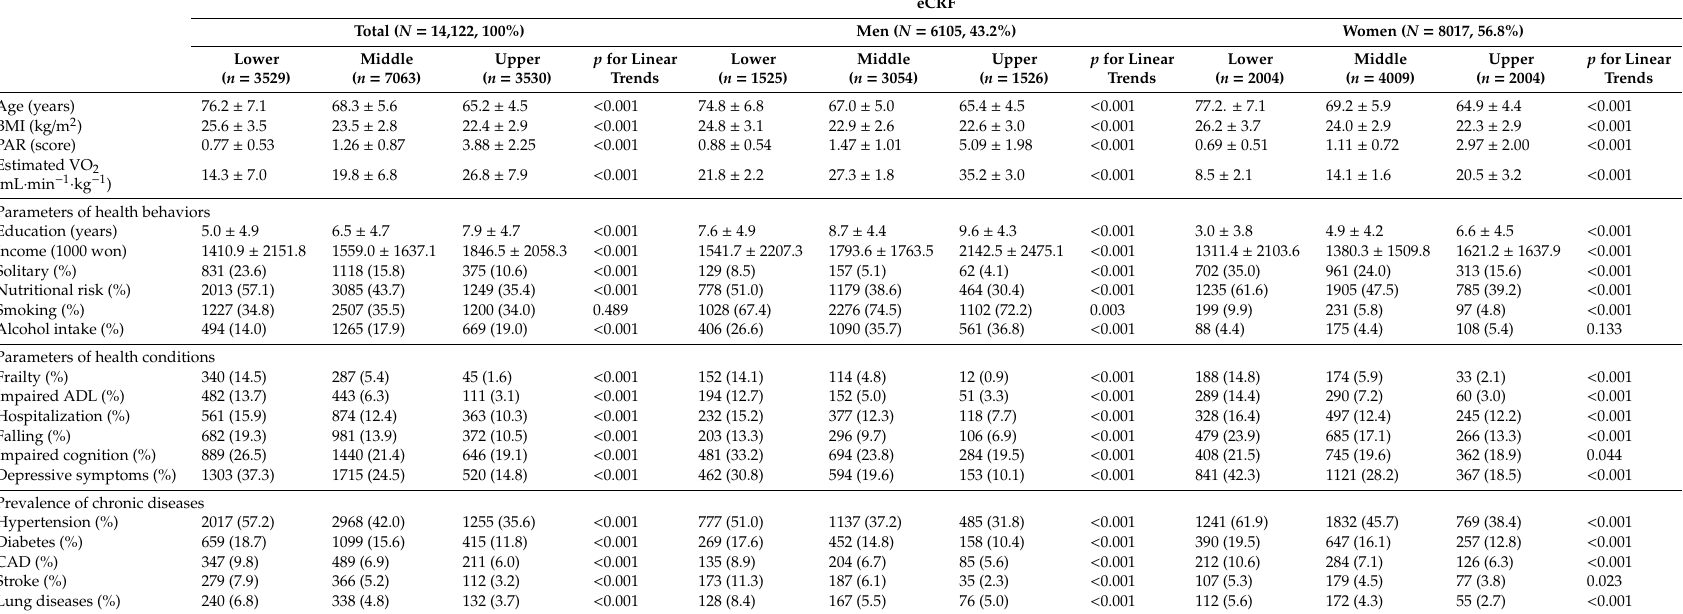
Table 1. Descriptive statistics of baseline characteristics according to eCRF